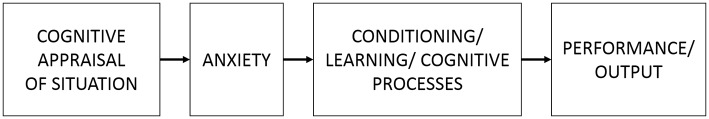
Scope of discussion addressing anxiety and performance.